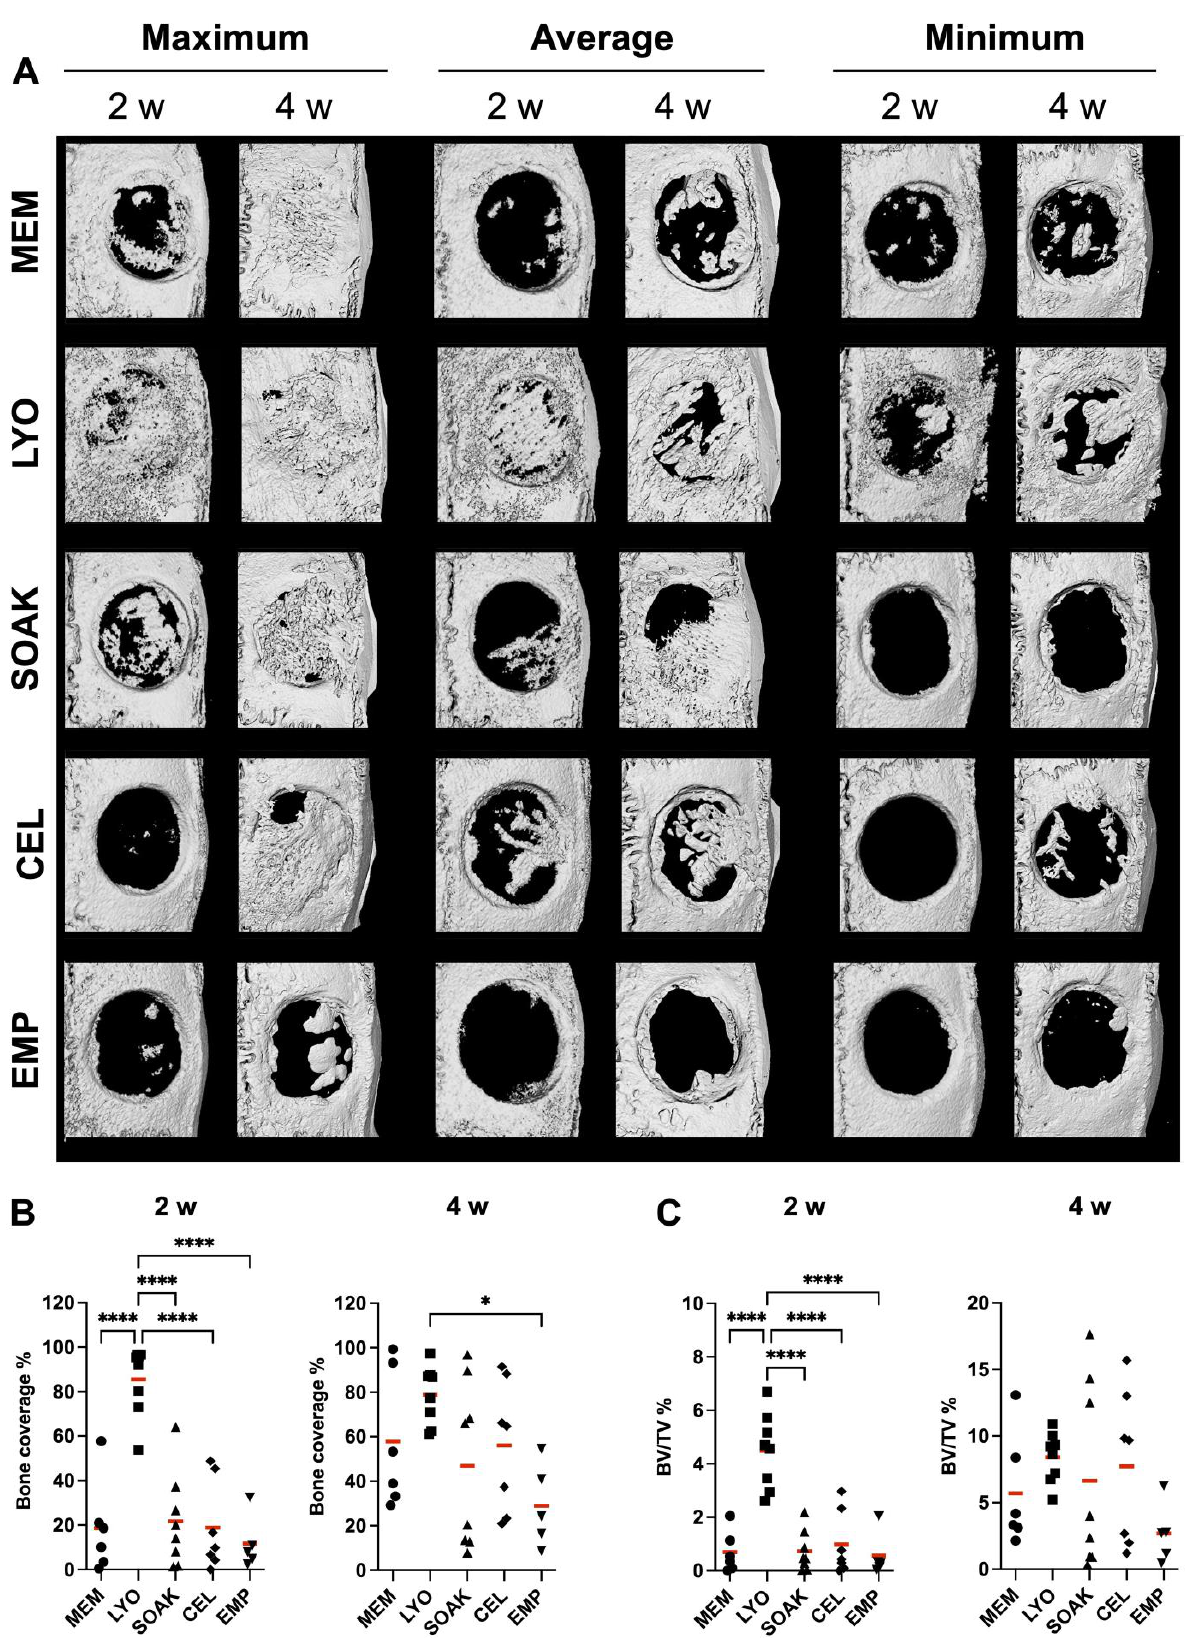
Figure 2. µ CT analysis. ( A ) Representative reconstructed µ CT images after 2 (in vivo) and 4